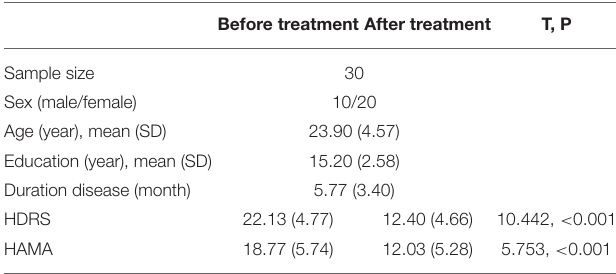
TABLE 1 | Demographic and clinical data. TABLE 2 | Microstate parameters in patients with MDD ( n =